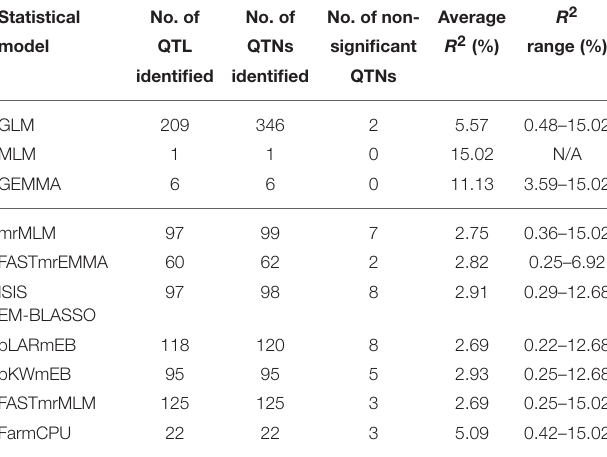
QTL differed depending on the statistical methods. QTL